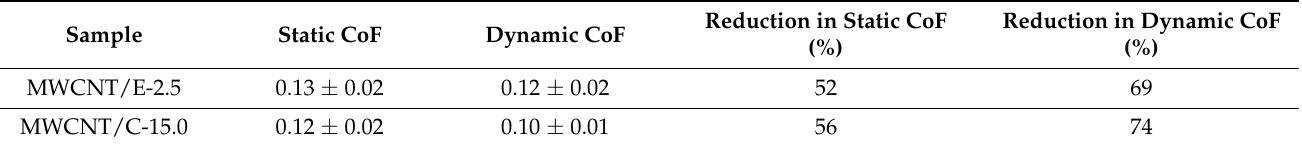
Table 9. CoFs of solid lubricants with different epoxy and MWCNT contents.